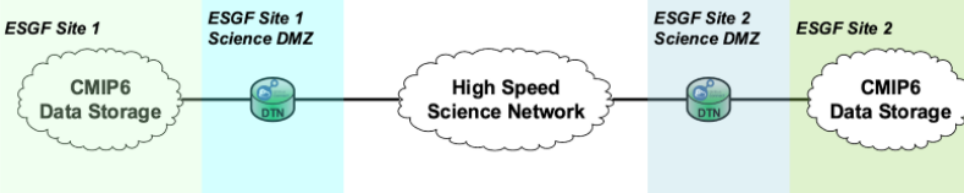
Figure 6. Data transfer